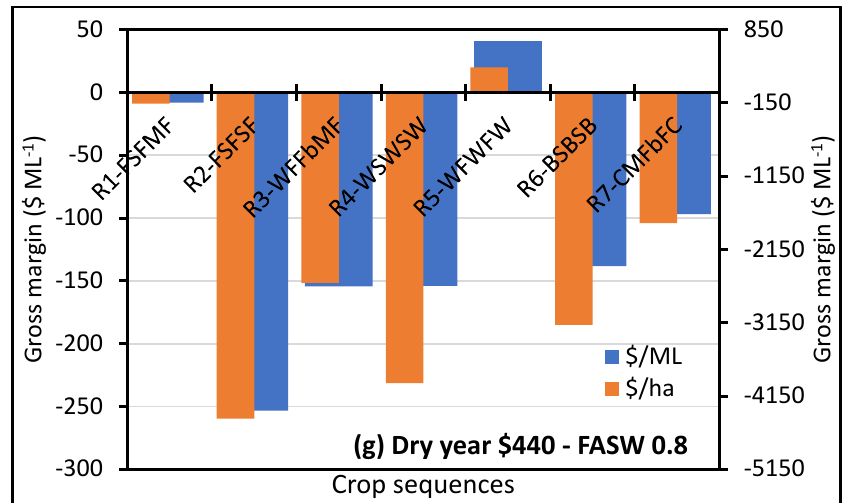
Figure 7. Total gross margin per unit of water and per cultivated land for different water prices ($) and available soil water fractions (FASW) as affected by crop sequences. Wet, medium, and dry refer to years with above average, average, and below average rainfall, respectively.